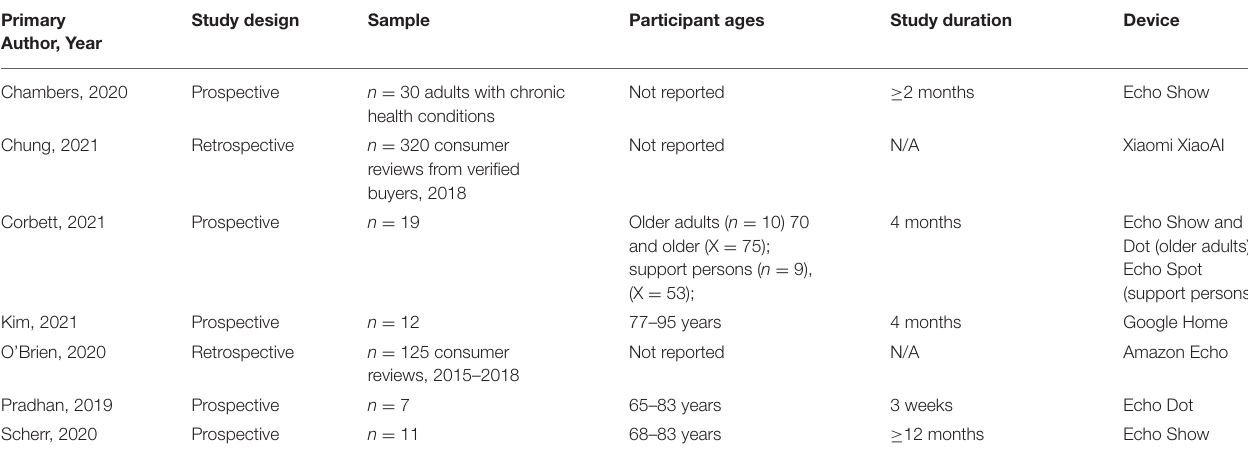
TABLE 2 | VHA study